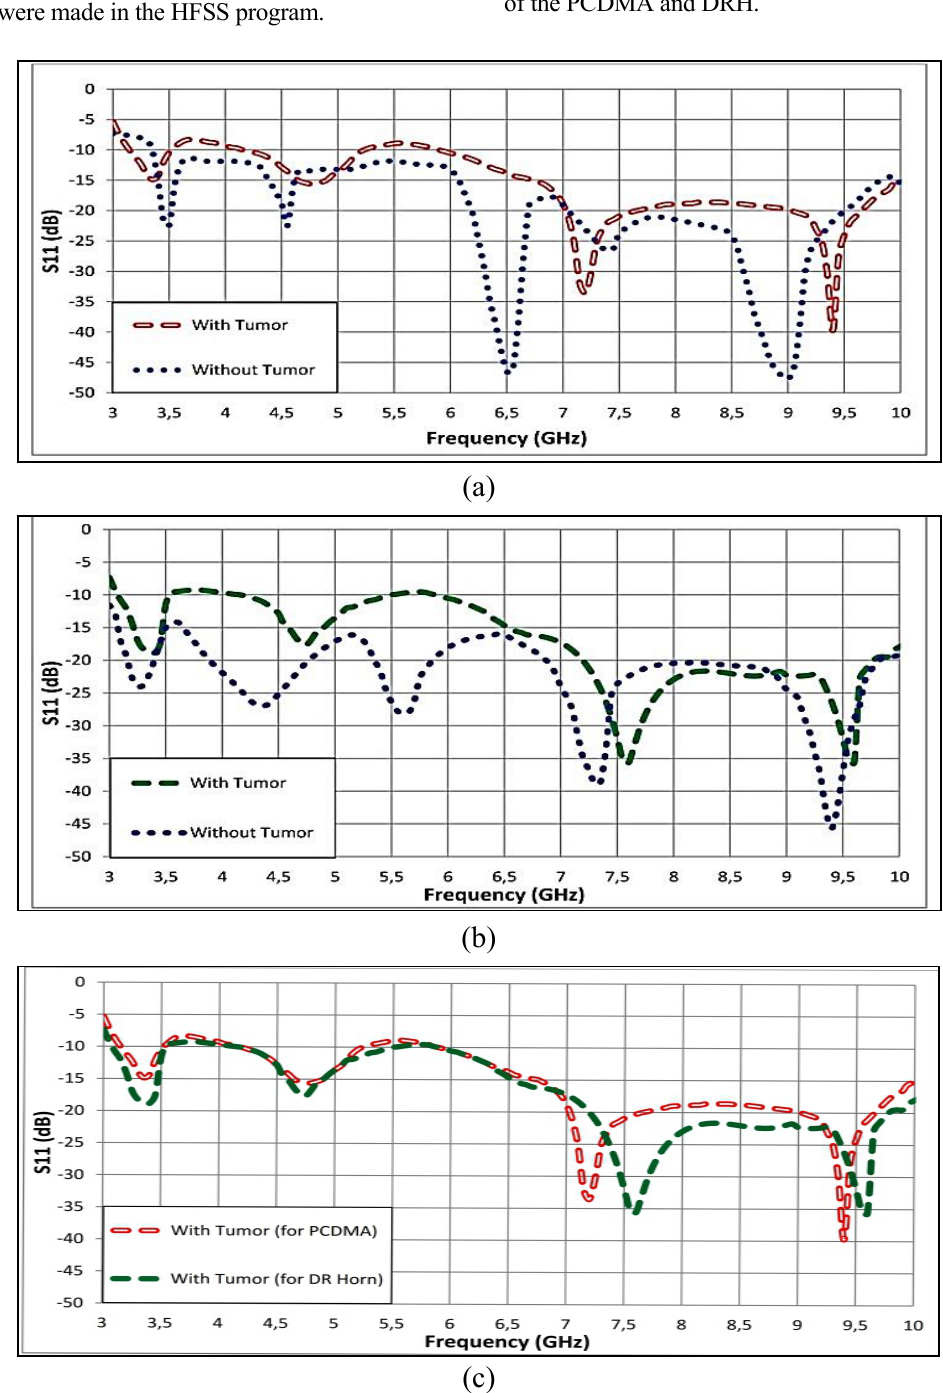
FIGURE 4. Simulated return loss results: a) obtained by using PCDMA, b) obtained by using DRH, c) obtained by using both DRH and PCDMA for tumorous